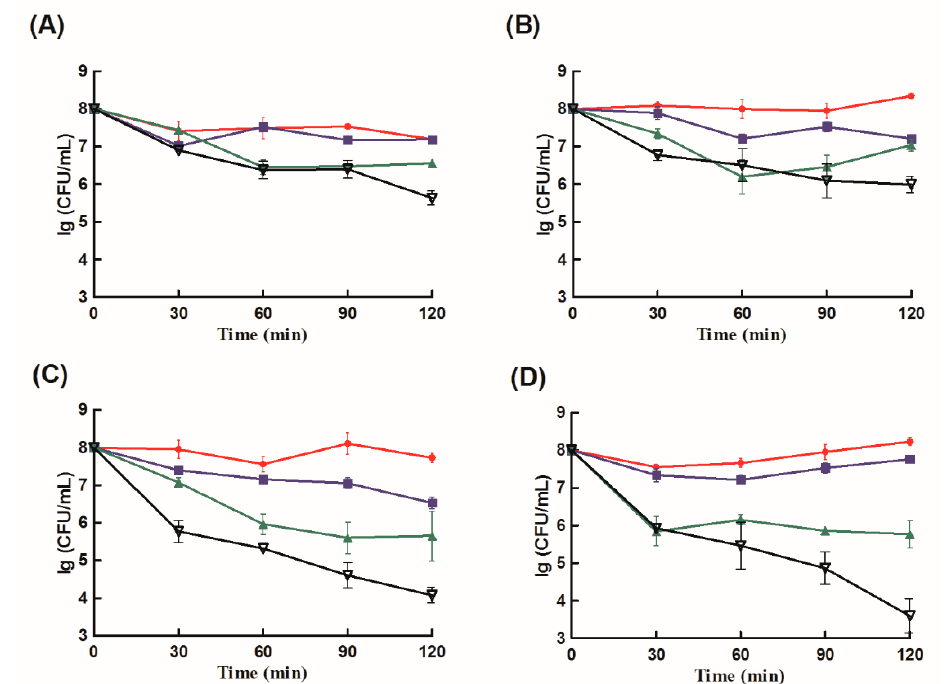
Figure 5. Antimicrobial activity kinetics of CS-NPs (red filled circles), free lysozyme (blue filled square), free lysozyme + CS-NPs complex (green filled triangle), and Lys-CS-NPs (black hollow triangle) for: P. aeruginosa ( A ); K. pneumoniae ( B ); E. coli ( C ); and S. aureus ( D ). lg, log10.